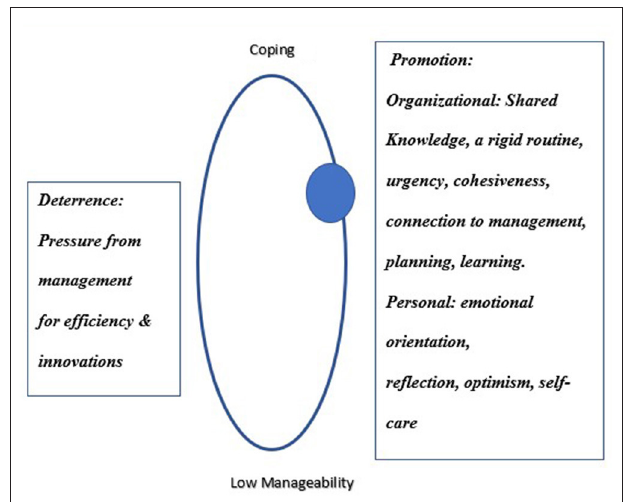
FIGURE 2 | The dynamic sphere of resilience on the manageability axis.